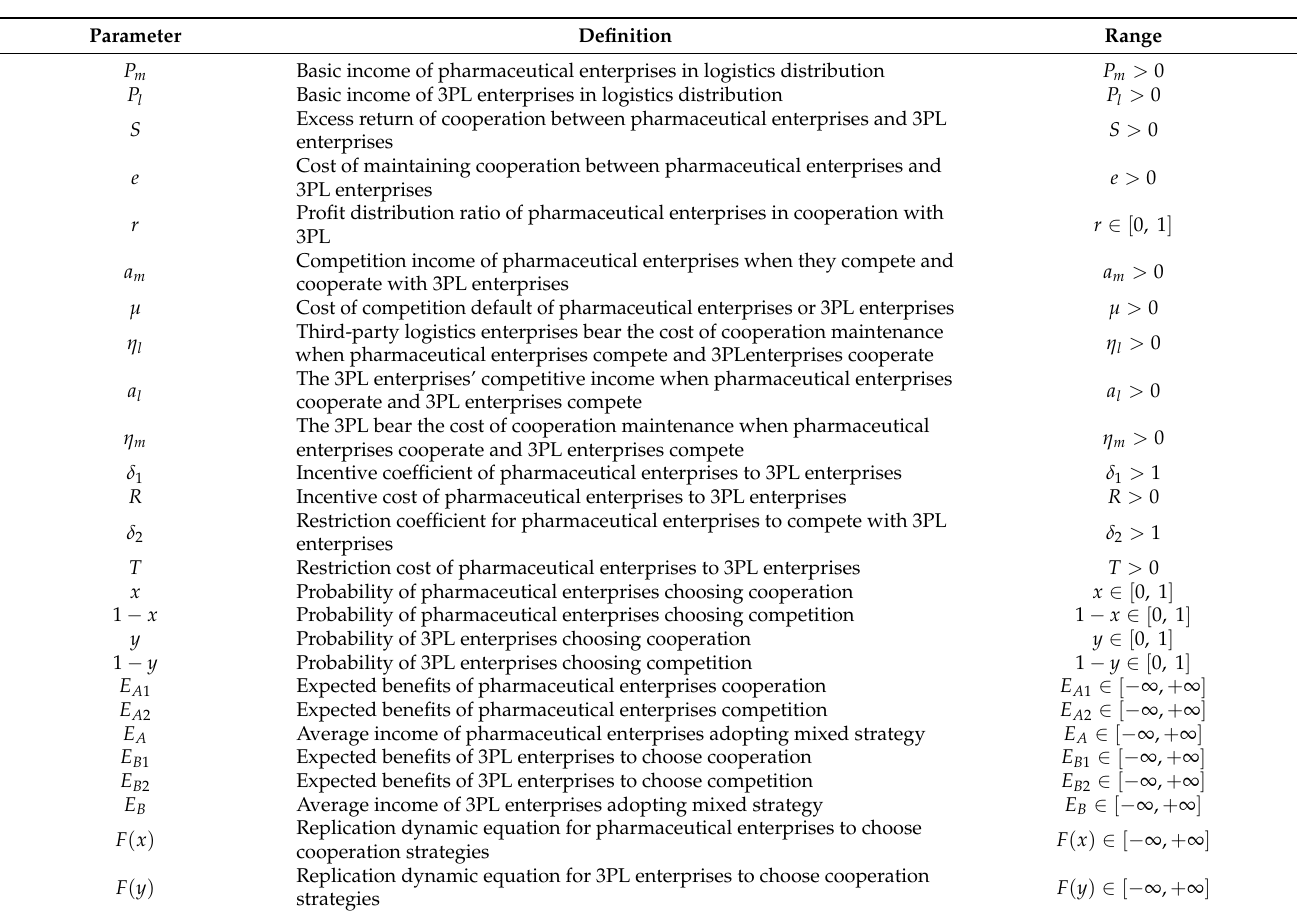
Table 1. Parameters and definitions.